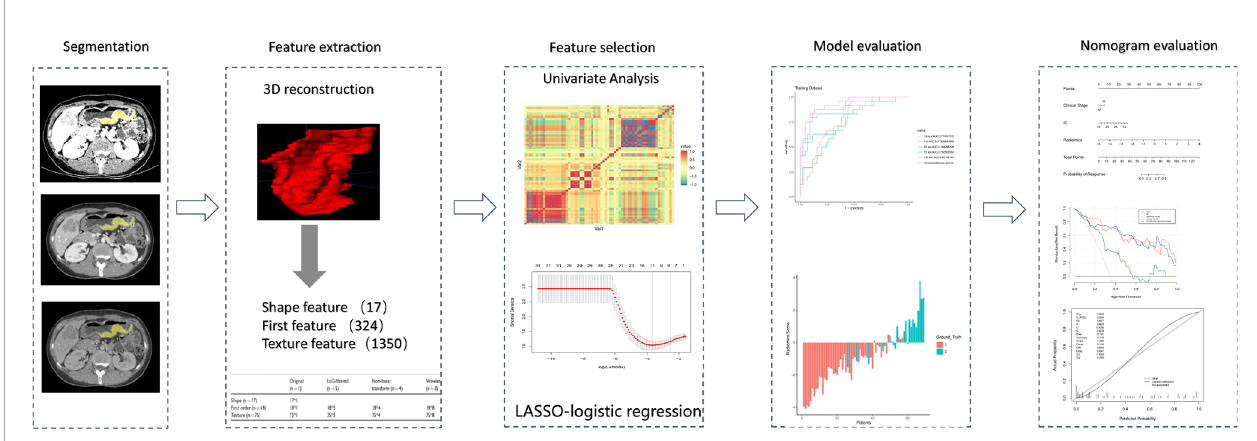
FIGURE 3 | Radiomics work fl ow of the present study. The radiomics procedure consists mainly of fi ve steps: volume of interest segmentation, feature extraction, feature selection, model evaluation, and nomogram